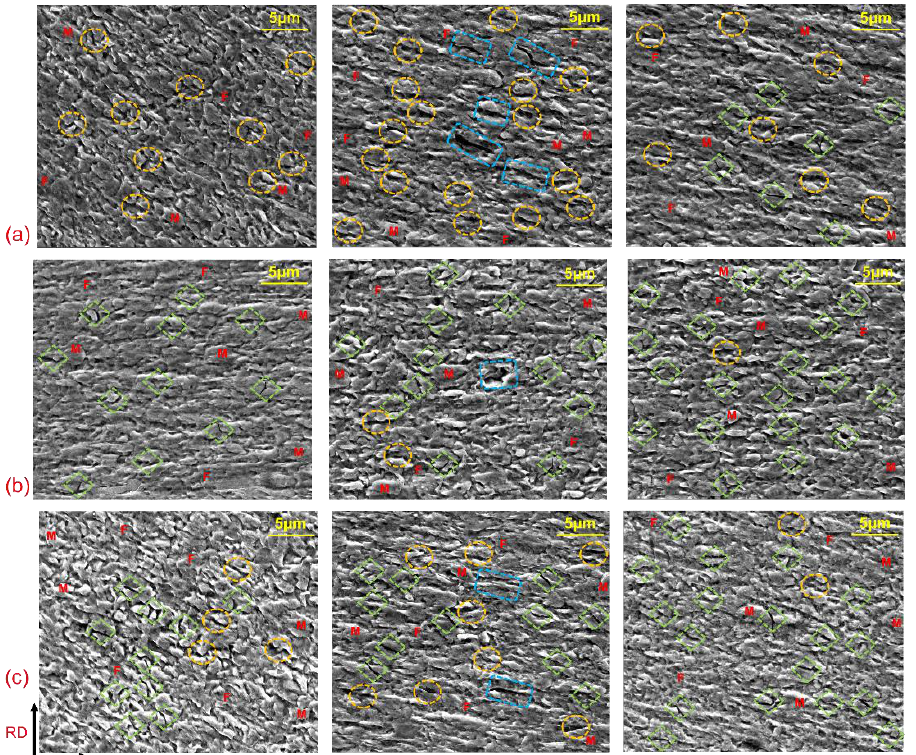
Fig.4 SEM micrographs of (a) CH (b) SH and (c) PS specimens at quasi-static (left), intermediate (middle) and dynamic (right) testing speeds. Interface debonding, ferrite-ferrite grain boundary decohesion and martensite cracking are indicated with yellow circles, blue rounded rectangles and green diamonds